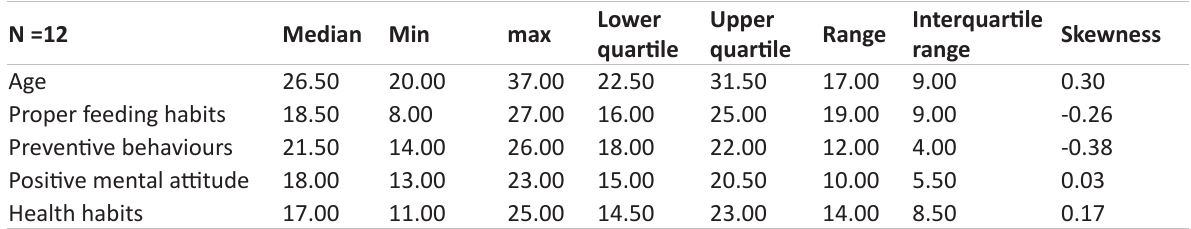
Table 2. The health-related behaviour, usually in everyday functioning, descriptive analysis. N =12